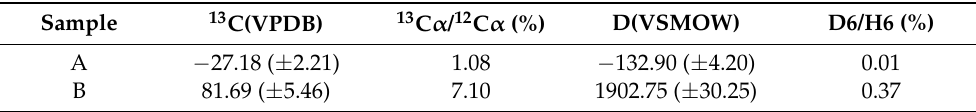
Table 1. 13 C and D abundance of Ginkgo